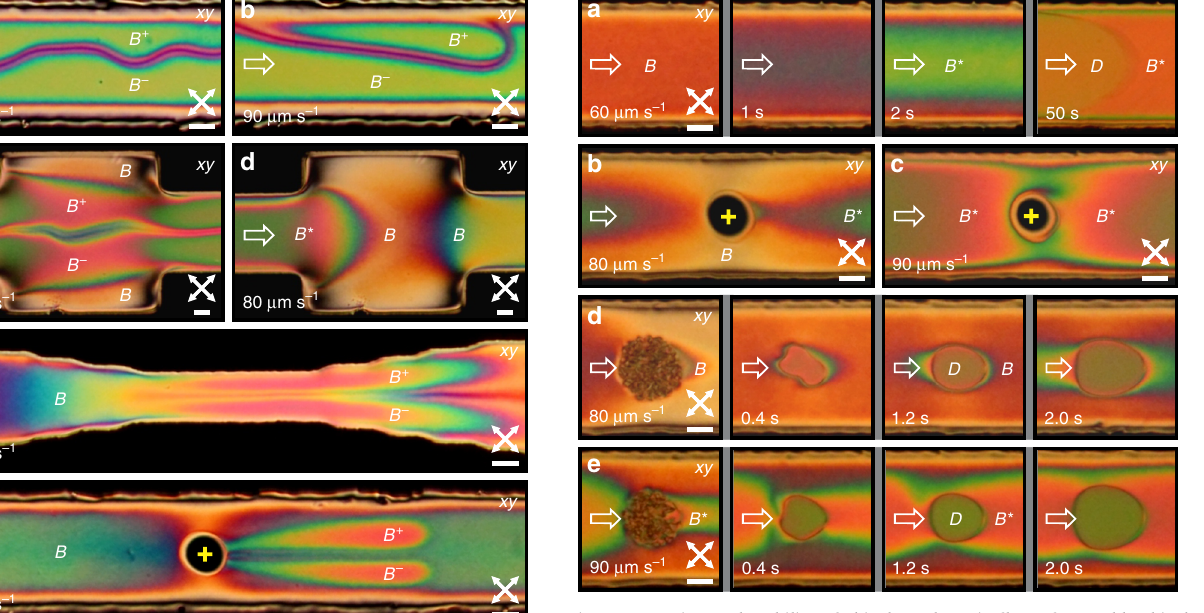
Fig. 3 Formation and stability of chiral B * phase in fl ow of a weakly chiral nematic. a Gradual transition from B phase to chiral B (cid:3) phase occurs at lower fl ow velocity and typically starts from the center of a channel. The small amount of right-handed chiral dopant triggers continuous growth of a single chiral domain with no soliton that is eventually transformed into fl ow-aligned D state. Note that with introduction of intrinsic chirality, the distinction between B and B (cid:3) states becomes blurred. b A static laser beam in a fl owing B (cid:3) phase generates a small isotropic region with different rheological properties that allows faster fl ow, slowing down the fl ow in the surrounding medium, which thereby transitions into the B state. c At higher fl ow velocity, the laser-induced isotropic island cannot split the wrapping B (cid:3) phase as it becomes suf fi ciently stable over long time and length scales. d Laser-induced nucleation of D domain in the B phase. While the domain is growing, it is getting surrounded by greenish-coloured B (cid:3) phase. e A similar experiment at higher fl ow velocity, where the fl ow is already in the B (cid:3) state before the quench, creating another D domain that is stabilised inside the B (cid:3) phase. Scale bars, 20 μ m